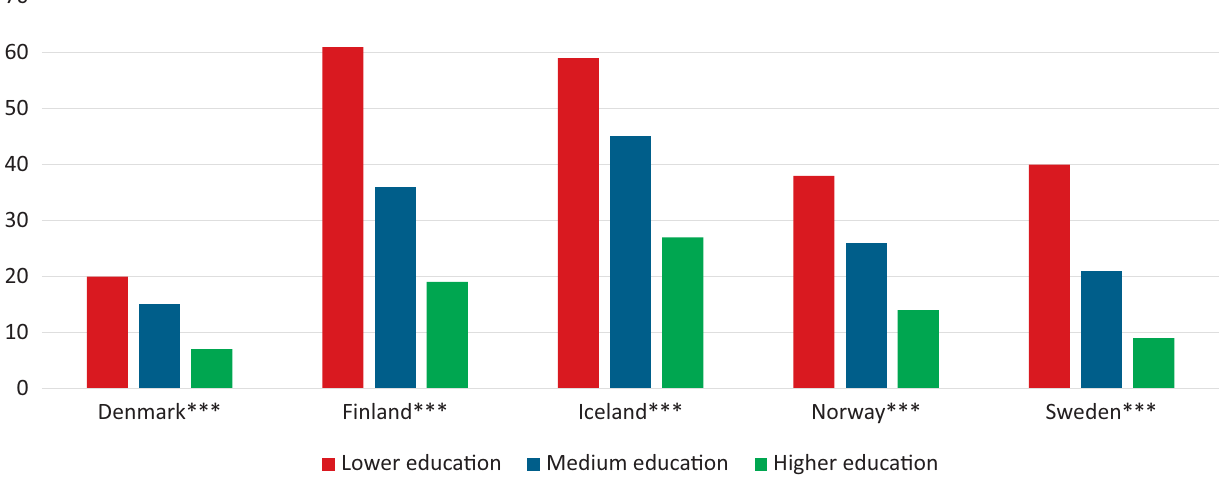
Figure 3. Percentage among different education groups agreeing that “a job is alright but what most women really want is a home and children” (all age groups, Nordic countries, 2017). Notes: *p < 0.05, **p < 0.01, ***p < 0.001; Denmark: n = 3,227, gamma = − 0.38; Finland: n = 1,140, gamma = − 0.51; Iceland: n = 1,986, gamma = − 0.42; Norway: n = 1,086, gamma = − 0.41; Sweden: n = 1,150, gamma = − 0.51.